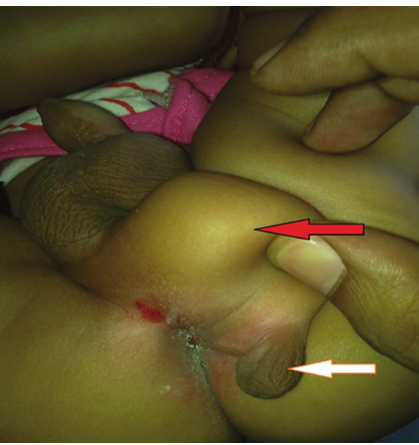
Figure 1: Red arrow shows intervening lipoma and white arrow shows accessory scrotum.